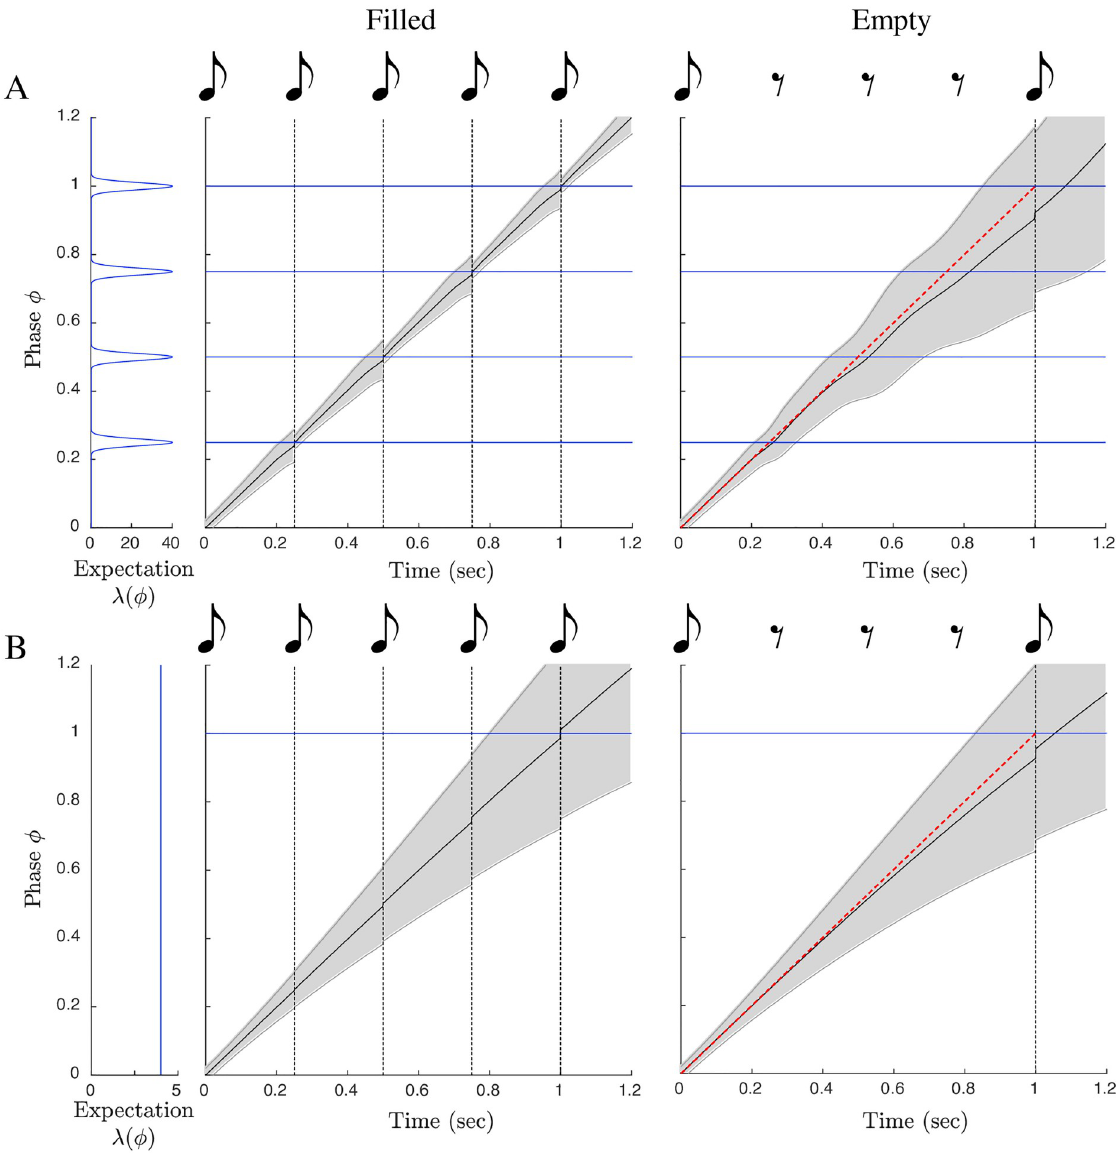
Fig 7. The filled duration illusion: Time warping by the omission of strongly expected events. (Same image key as 4, with shading displaying PATIPPET phase variance.) A) PATIPPET is simulated with strong expectations for isochronous events. Left: When a set of strongly expected events occur as expected (a filled duration), estimated phase stays on track, advancing (on average) at a rate of 1. Right: When the duration is empty, estimated phase deviates from steady progression (red diagonal) by dragging as each expected event point approaches and passes, leading to the illusion that the event marking the end of the interval has arrived earlier than expected. B) PATIPPET is simulated with a high expected background rate of events λ 0 , but no phase-specific event expectations ϕ i . In this case, too, an empty duration leads to dragging estimated phase and an unexpectedly early final